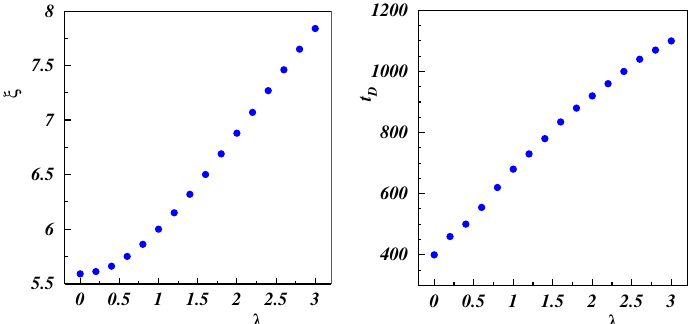
Figure 2. Interface width ξ ( left panel) and diffusion time t D ( right panel) as functions of the activity λ